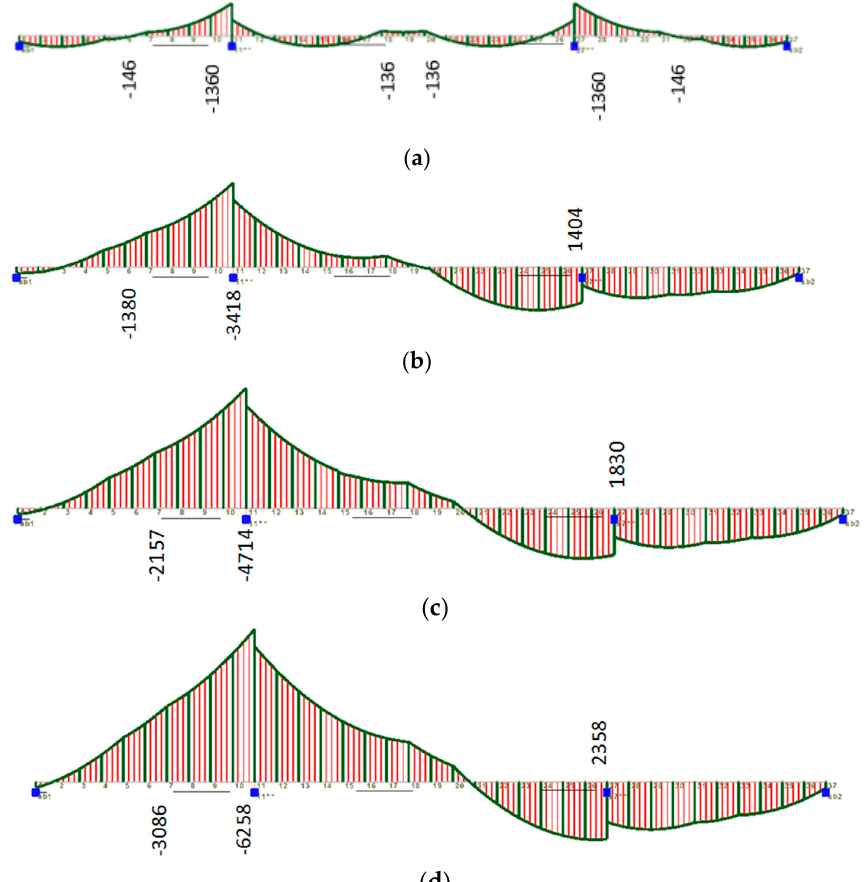
Figure 18. ( a ) Bending moment diagram—initial state (units in kN·m). ( b ) Bending moment diagram—settlement of 0.08 m under S2 (units in kN·m). ( c ) Bending moment diagram—settlement of 0.20 m under S2 (units in kN·m). ( d ) Bending moment diagram—settlement of 0.64 m under S2 (units in kN·m). (*, ** nodes at the